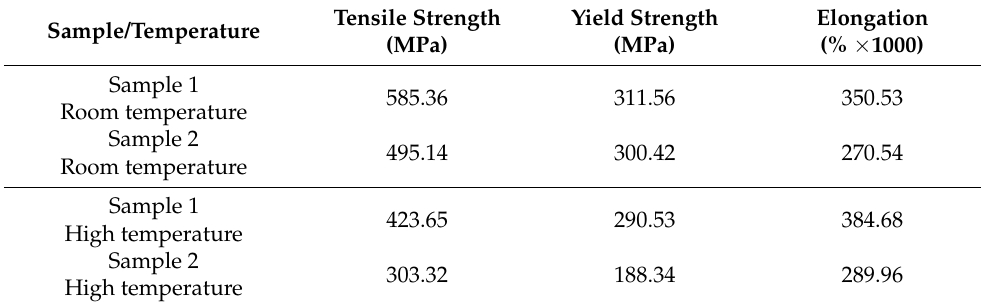
Table 2. Tensile test of Sample 1 and Sample 2 at room temperature and high